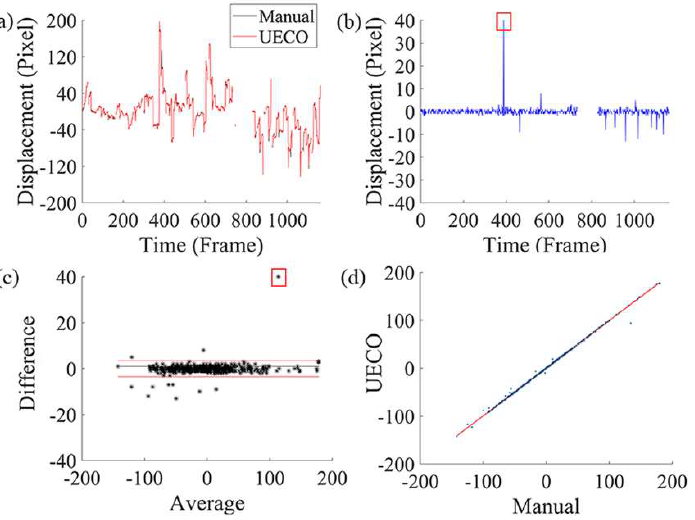
Figure 6. Horizontal displacement comparison chart; ( a ) shows the comparison of the horizontal displacements obtained by UECO and manual registration; ( b ) is the difference between the two methods; and ( c ) is the Bland−Altman plot. The black line is the mean difference of the two methods. Red lines indicate the 95% confidence interval (mean ± 1.96 × standard deviation). The Pearson correlation coefficient curve is shown in ( d ). The frames with the largest differences have been marked with red boxes. The frame number in the x-axis corresponds to the frame number in the original video.